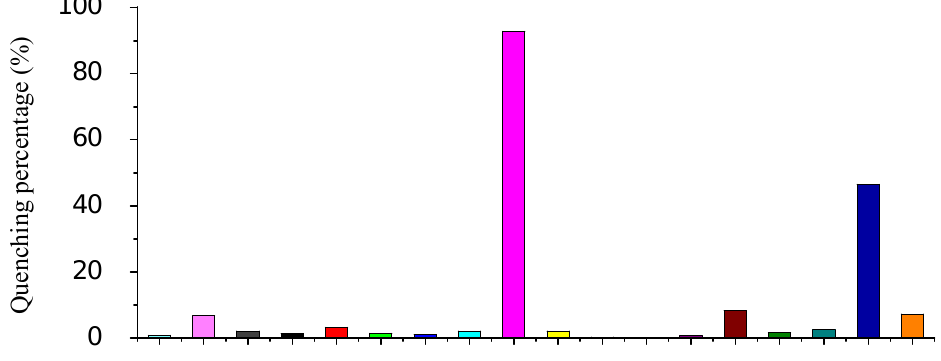
Figure 3. Quenching percentage [(I (5 × 10 -5 mol/L) upon the addition of 1.0 equiv metal ions in H Excitation wavelength is 320 nm. Emission wavelength is 490